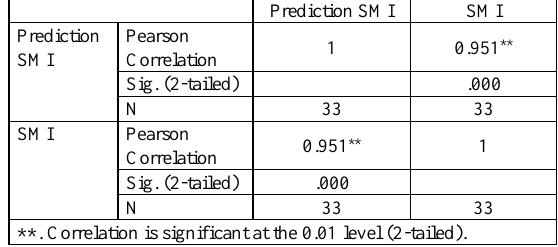
Table 3. Correlations between the PSMI and SMI Also, there are significant positive relationship between ground truth measurement and PSMI (p<0.001) in the table 4 and figure 9. The ground measurement data was compared with the PSMI from the model ( R 2 =0.65) (Figure 9).